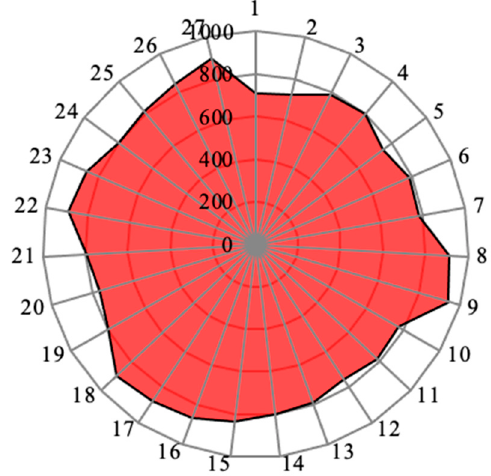
Figure 30. Cutting force (N) results for each specimen as radar diagram.